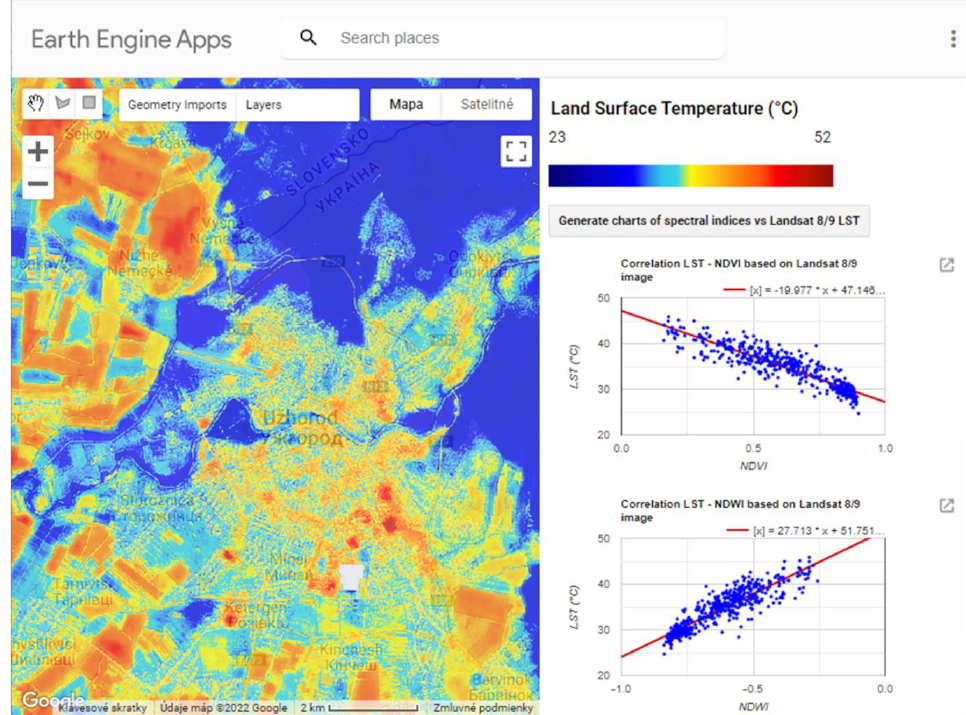
Figure 10. Example of the custom output of the implementation of the L8 LST downscaling at 10 m resolution, over the city of Uzhgorod, Ukraine, in Google Earth Engine.